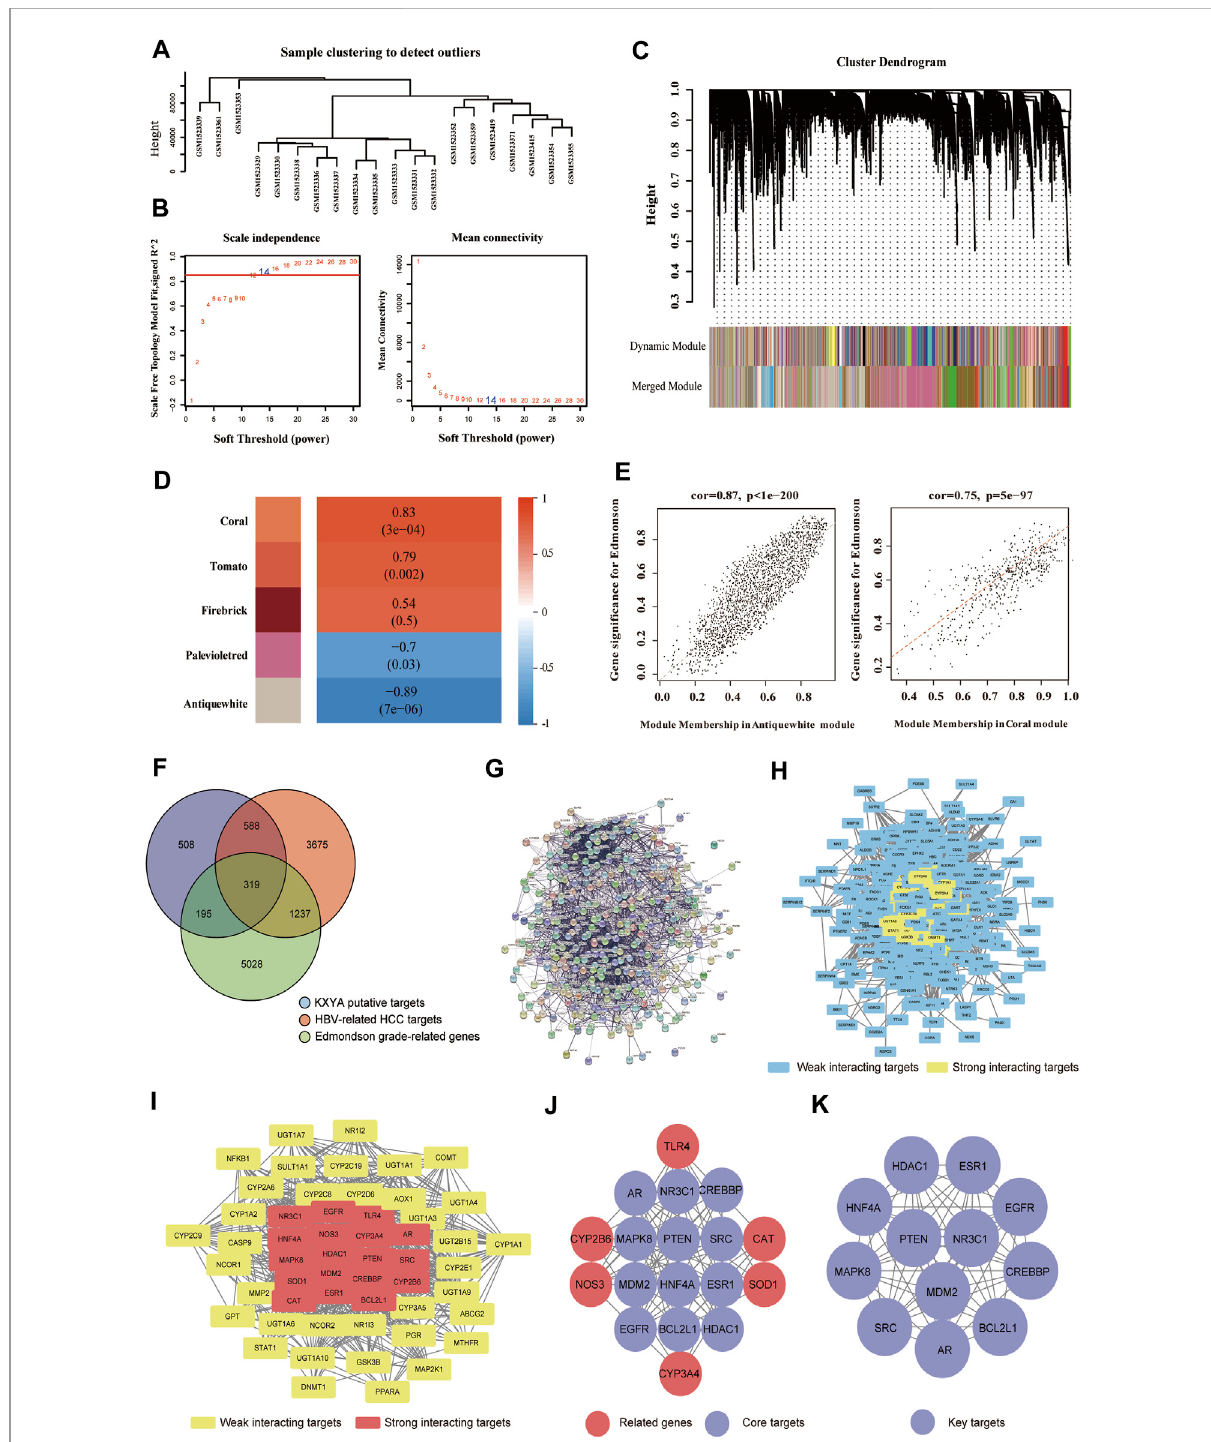
FIGURE 4 Obtained the key targets of KXYA on HBV-related HCC by network pharmacology analysis. (A) The sample clustering of the samples used in GSE62232 database. (B) The scale-free network analysis for samples in GSE62232 database. (C) The clustering dendrograms and modules for samples in GSE62232 database. (D) The heatmap of the top-5 modules, ranked by correlation between module genes and clinical traits of pathologicalgrade. (E) ThescatterplotofgenesintheCoralandAntiquewhitemodules. (F) Theoverlappedgenes(OGEs)ofKXYAtreatmenton HBV-related HCC, the blue circle represents KXYA putative targets, the red circle represents HBV-related HCC targets, and the green circle represents Edmonson grade-related genes. (G) The protein-protein interaction network of OGEs in STRING. (H) The protein-protein interaction